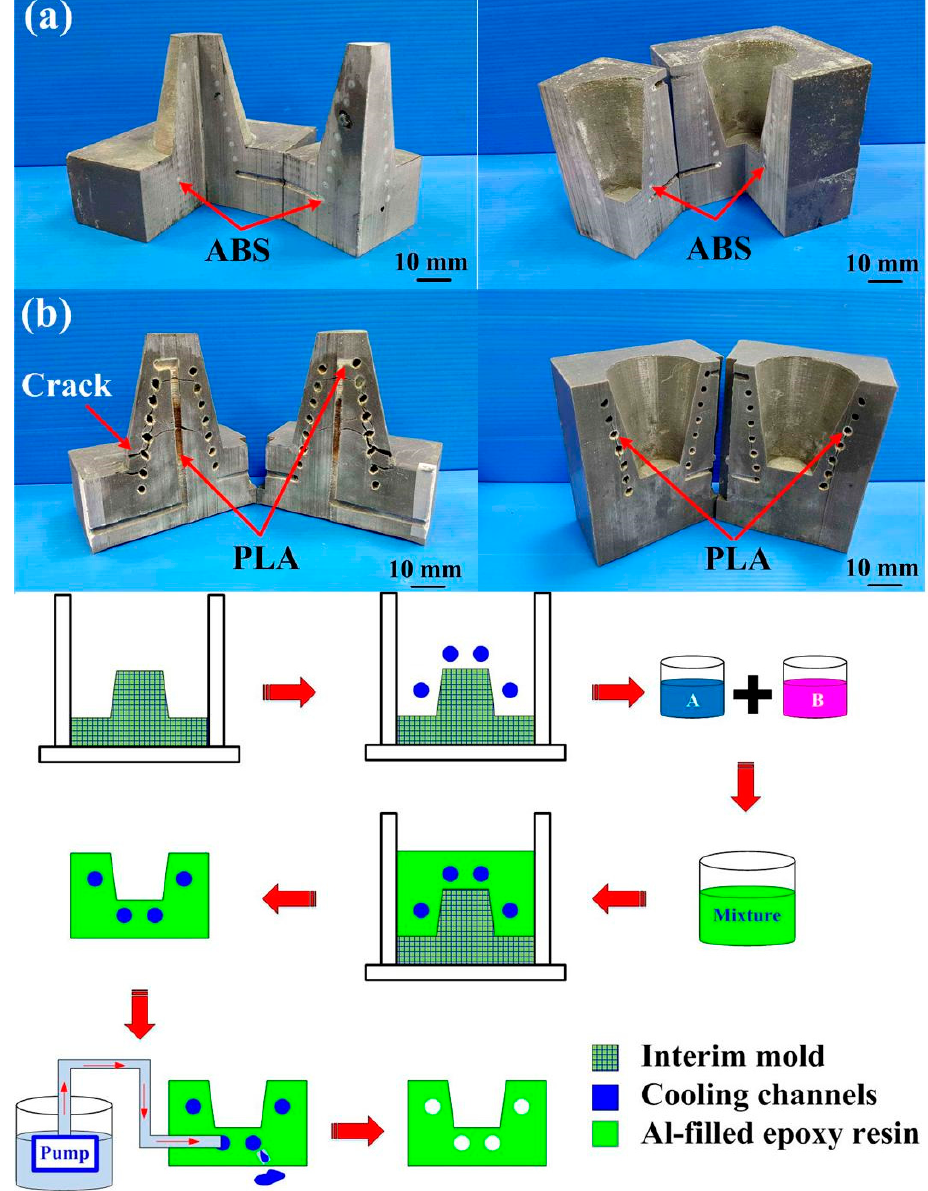
Figure 16. Failed injection molds with ( a ) ABS and ( b ) PLA cooling channels